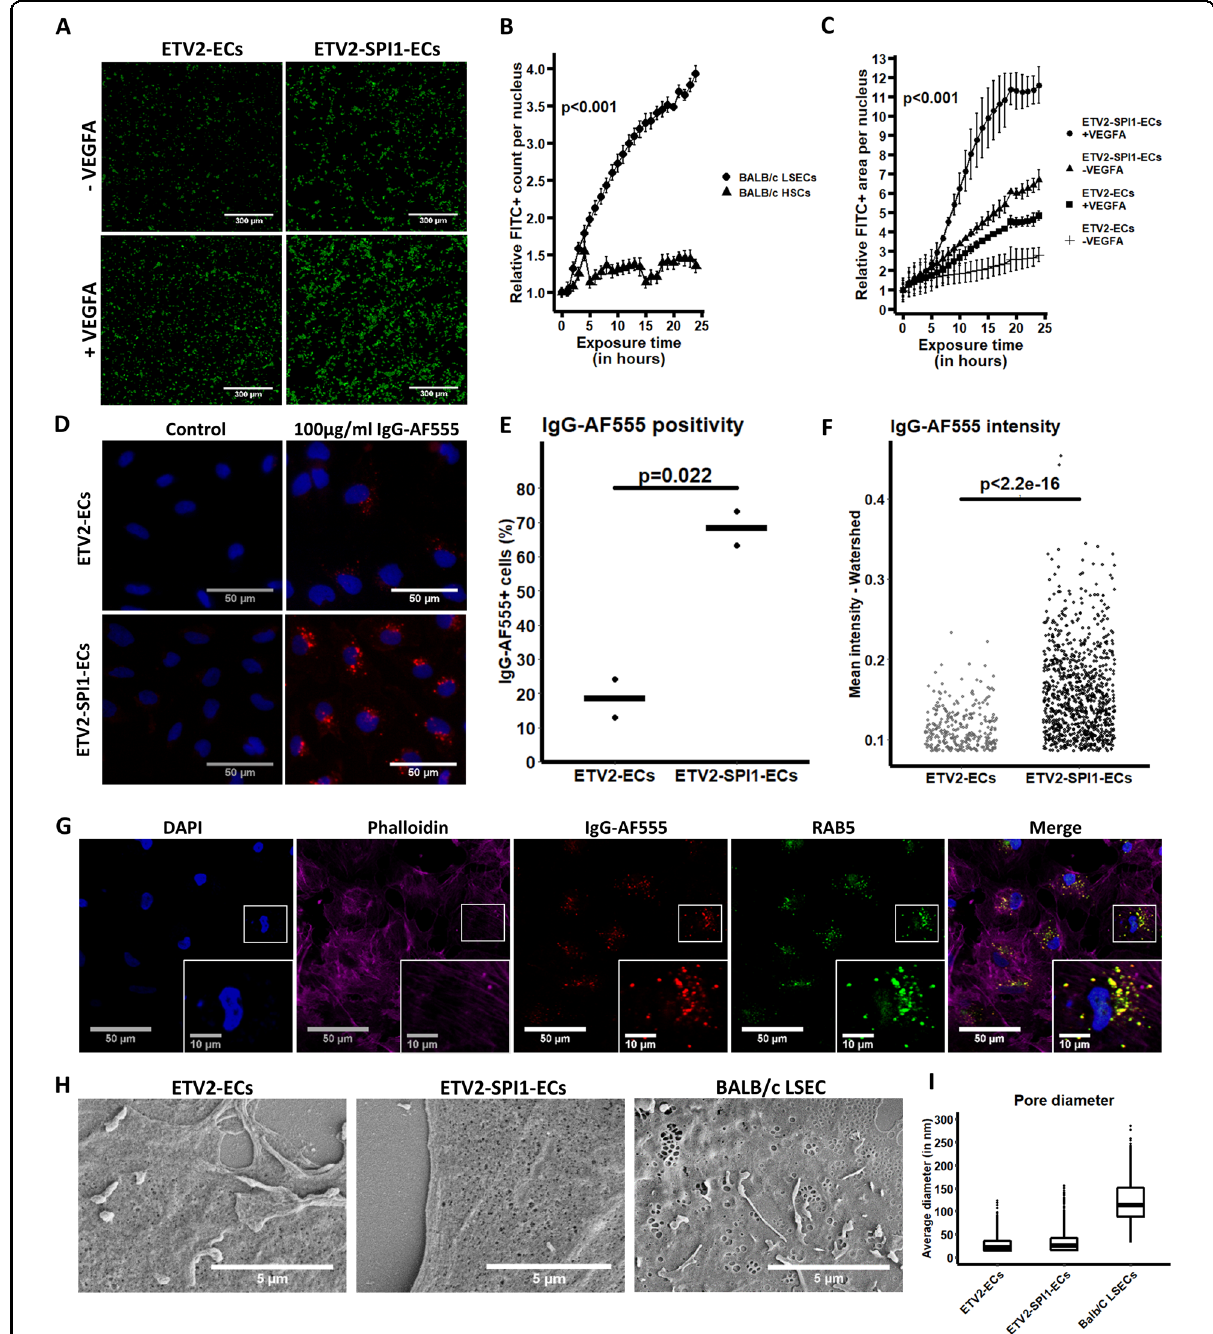
Fig. 7 LSEC-speci fi c functional characterisations of ETV2-ECs and ETV2-SPI1-ECs. A – C FSA-FITC uptake assay ( N = 2 biological replicates) on ETV2-ECs and ETV2-SPI1-ECs with and without addition of VEGFA, as well as on BALB/c LSECs and hepatic stellate cells (HSCs). Images are representative for 24 h exposure to FSA-FITC. Scale bars are 300 µm. FITC fl uorescence was measured every hour. Statistical differences were assessed by mixed ANOVA. D IgG-AF555 uptake assay. ETV2-ECs and ETV2-SPI1-ECs were exposed for 2 h to 100 µg/ml IgG-AF555 to measure the clathrin- mediated endocytosis of IgGs upon their binding to CD32B. Scale bars are 50 µm (representative example of N = 3 biological replicates). E Comparison of the percentage of IgG-AF555-positive cells in ETV2-ECs and ETV2-SPI1-ECs at day 12 of differentiation. Statistical assessment by Student ’ s T test. F Comparison of the AF555 intensity of IgG-AF555-positive cells in ETV2-ECs and ETV2-SPI1-ECs at day 12 of differentiation. Statistical assessment by Wilcoxon rank-sum test. G Confocal imaging of ETV2-SPI1-ECs exposed to IgG-AF555. Cells were co-stained with an anti-RAB5 antibody to evaluate co-localisation of IgG-AF555 and endosomes. H Scanning electron microscopy of ETV2-ECs, ETV2-SPI1-ECs, and BALB/c LSECs. Scale bars are 5 µm (representative example of all cells per coverslip). Average pore diameters are shown in I